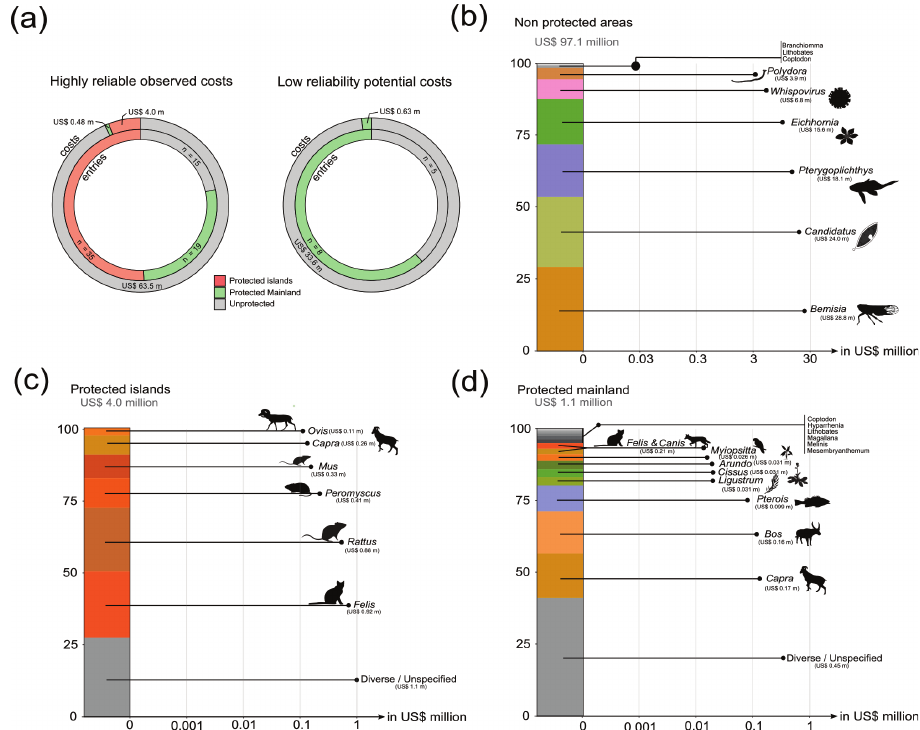
Figure 3. Invasion costs of invasive alien species with regards to the protection status of lands a relative number of entries and invasion costs in unprotected lands, protected islands and protected mainland for robust cost estimates (reliable and observed costs), and for non-robust cost estimates (unreliable and/or potential costs). Invasion costs in b unprotected lands c protected islands and d protected mainlands, considering percentage cost contributions in Mexico across taxa. For ( b, c and d ) costs include reliable and unreliable as well as observed and